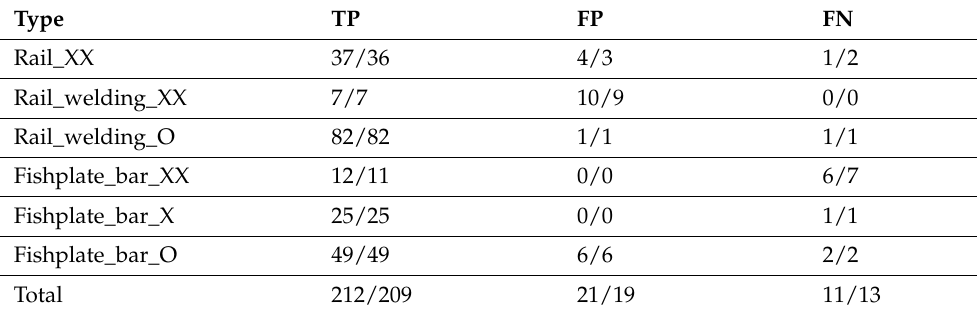
Table 17. SSD512/300 training results of the side view.